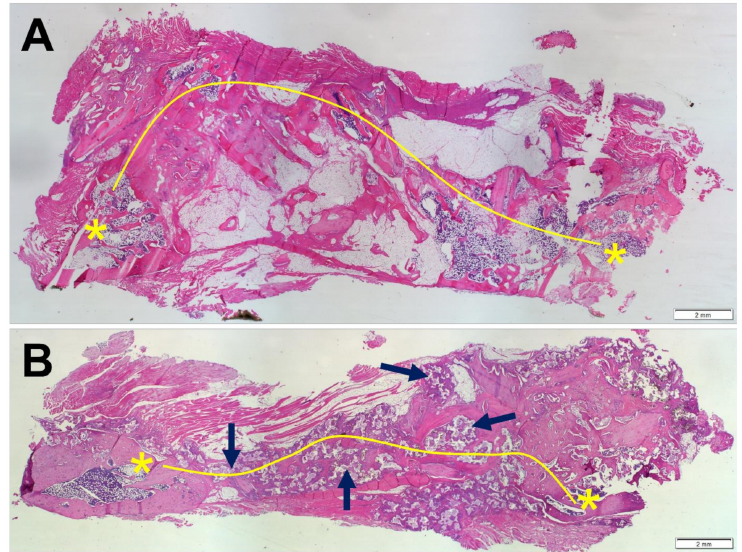
Figure 6. Overview of the histological panels (H&E) of the fusion masses present in the spine of ( A ) ABG and ( B ) BCP-EP/ABG at 12 weeks after surgery. Both fusion masses were evaluated as fused since a continuous bone mass (yellow line) was present between the transverse processes (yellow asterisk). The presence of BCP granules in the newly formed bone was confirmed in the BCP-EP/ABG group (black arrows).